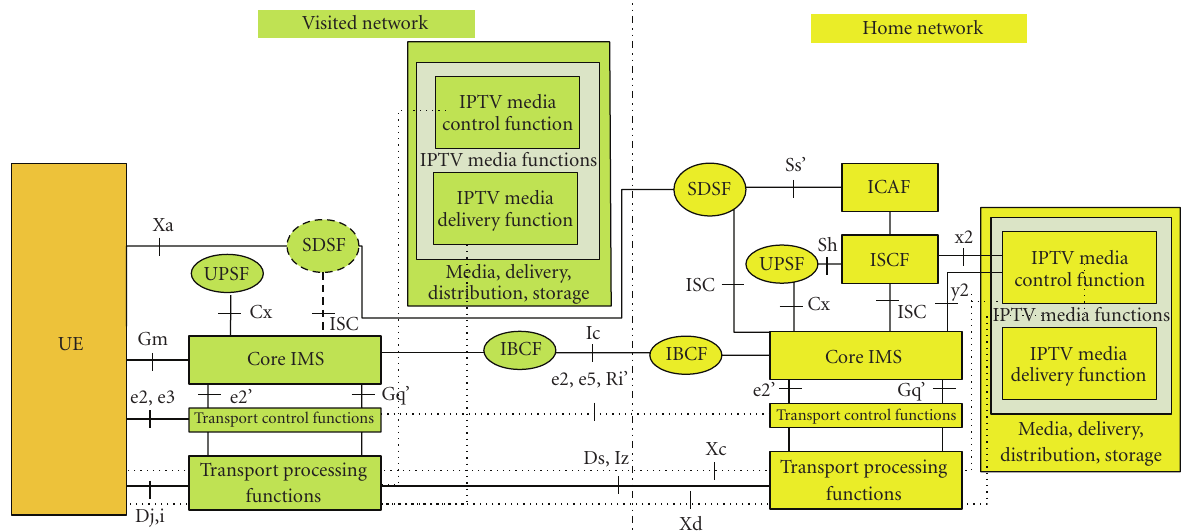
Figure 6: Model of interconnection with the Visited Network with